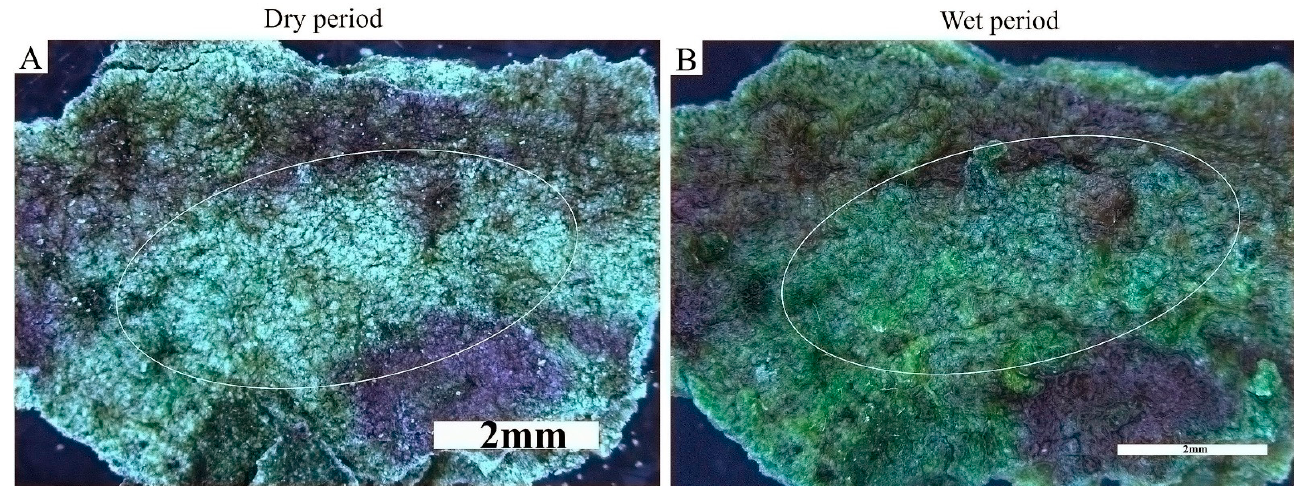
Figure 5. The response of biocrusts to hydration. The appearance of biocrusts is different under dry conditions ( A ) and 15 min after wetting ( B ). The watering changed the appearance of the less colonized parts of the sediment ( A ) into a dark, continuous biofilm ( B ).